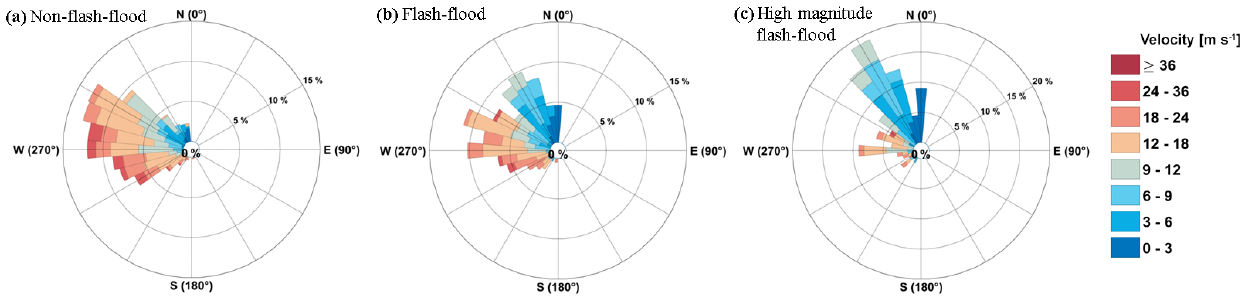
Figure 11. Advection (velocity and direction) distributions of dominant rain cells for (a) non-flash-flood events (490 cells, 144 events), (b) flash-flood events (220 cells, 29 events), and (c) high-magnitude flash-flood events (111 cells, 15 events). High magnitude is defined based on median values of measured flash floods in Darga and Teqoa used in this